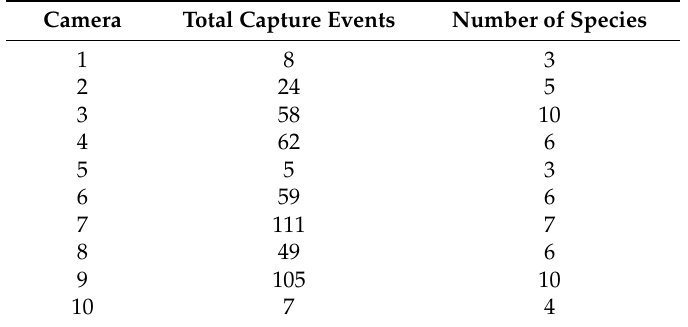
Table 4. Mammal capture events and number of species at each camera along the 20 km studied section of railway from 2015 to 2016.